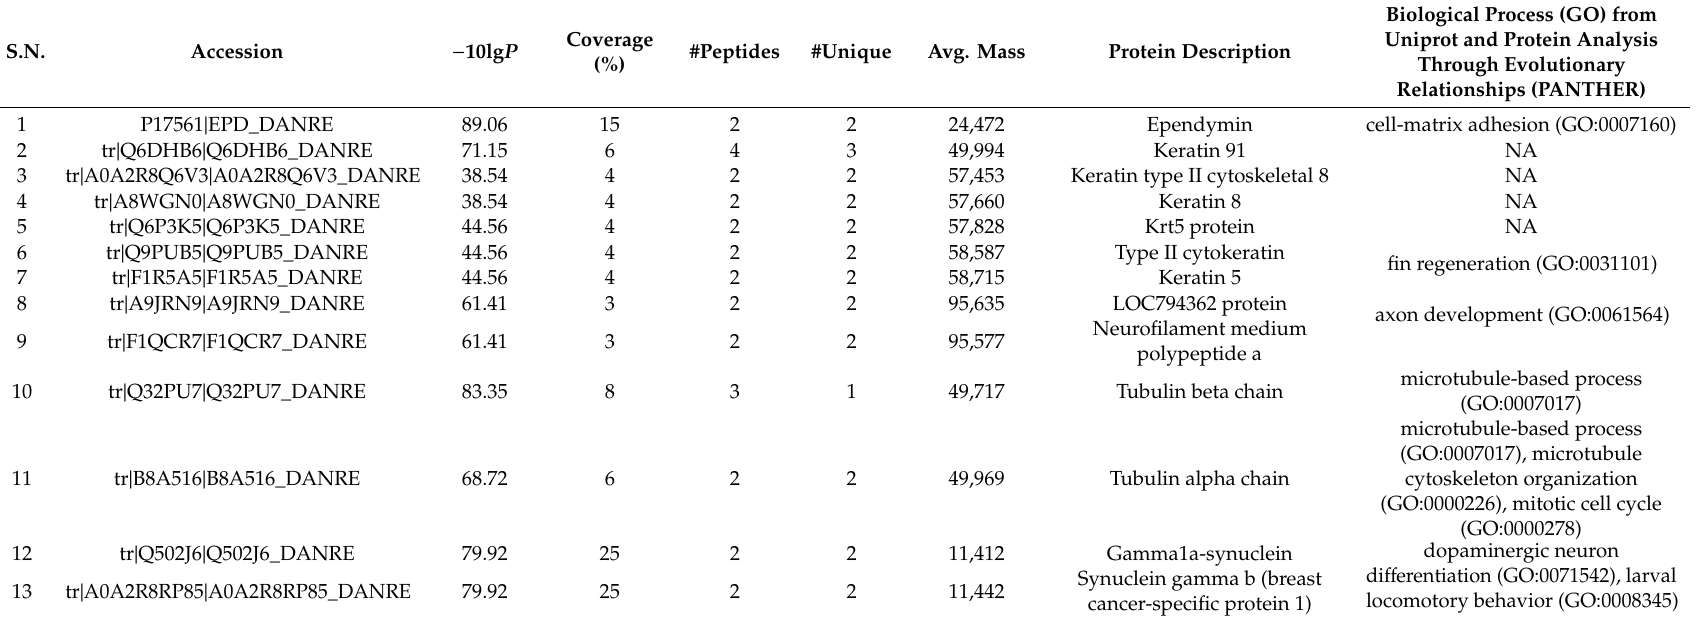
Table 2. List of 13 proteins identified by LCMS / MS from Zebrafish epileptic brain protein